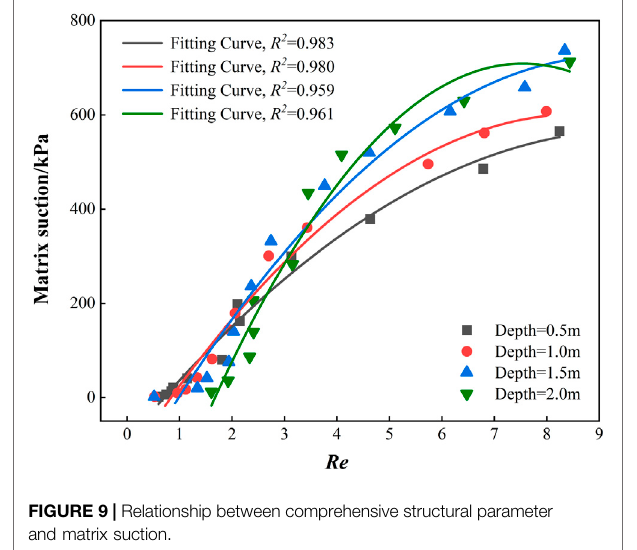
FIGURE 9 | Relationship between comprehensive structural parameter and matrix suction.